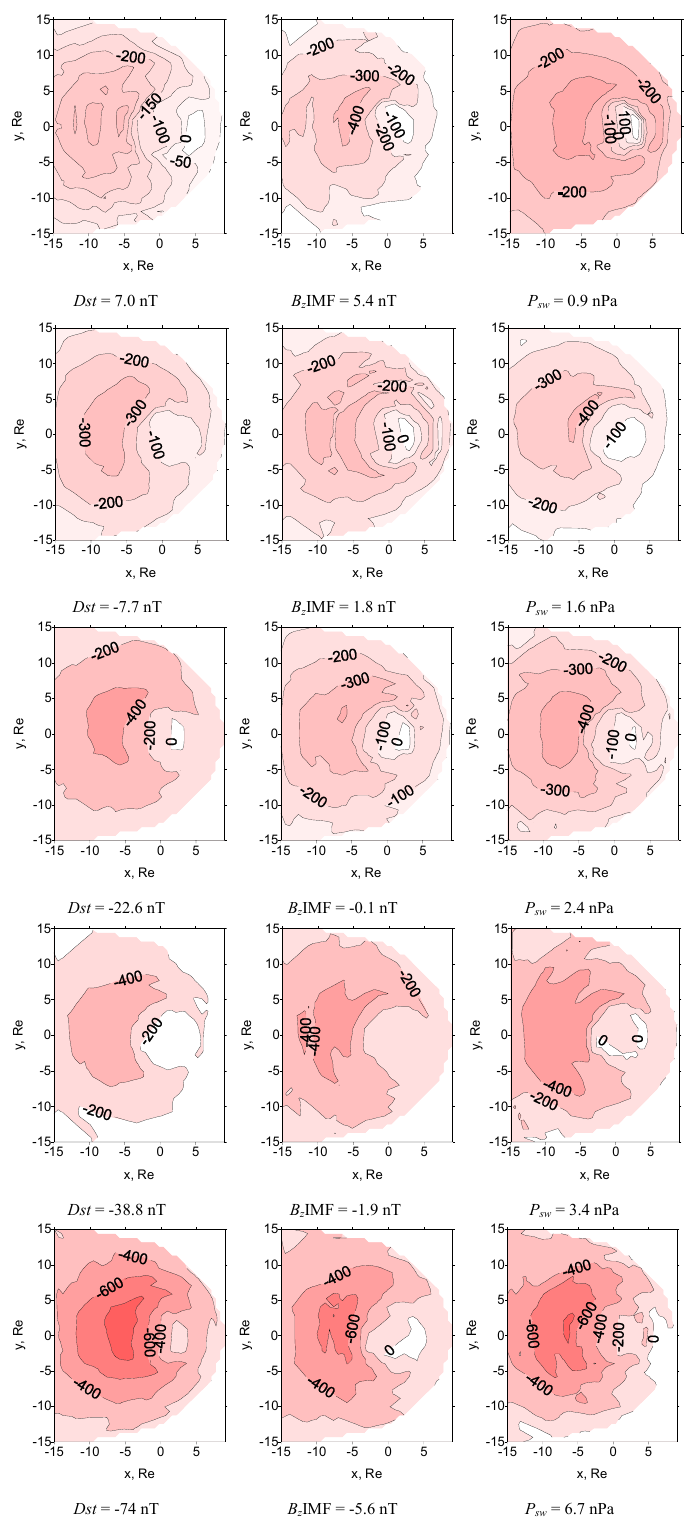
Figure 1. Surface density (in kA/ R E ) of the azimuthal (eastward) component of the electric current in the sheet of − 3 < z < 3 R E .